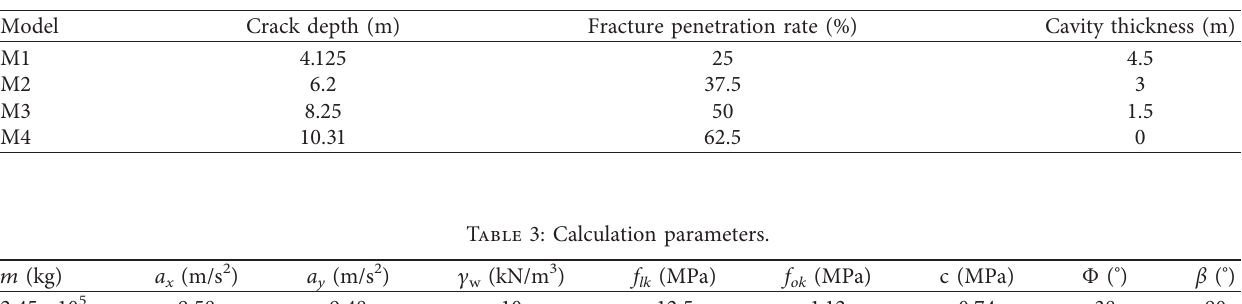
Table 2: Weathering situation of each model cavity and fissure.